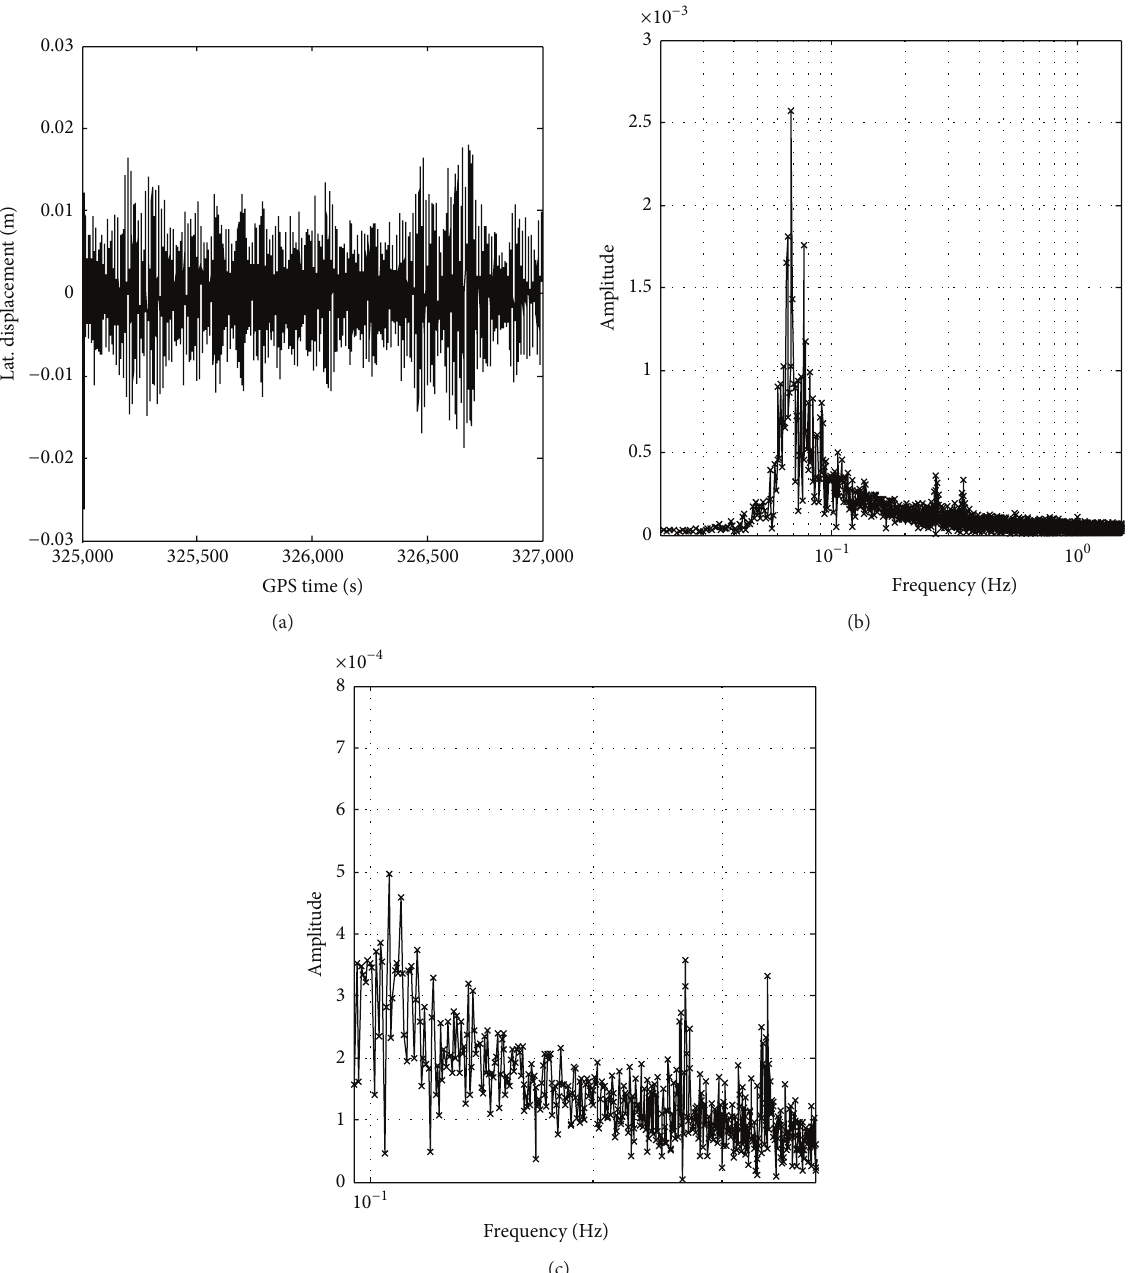
Figure 15: The filtered lateral displacements (a), corresponding vibration frequency ((b), full-scale band), and zoom-in of high frequency component (c) during the wind speed decreasing